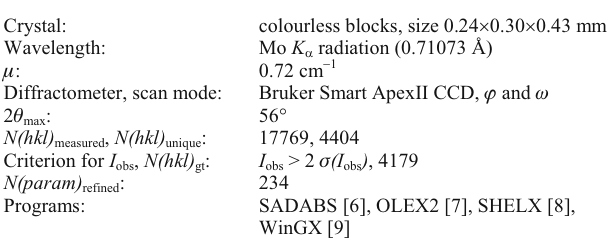
Table 1. Data collection and handling.